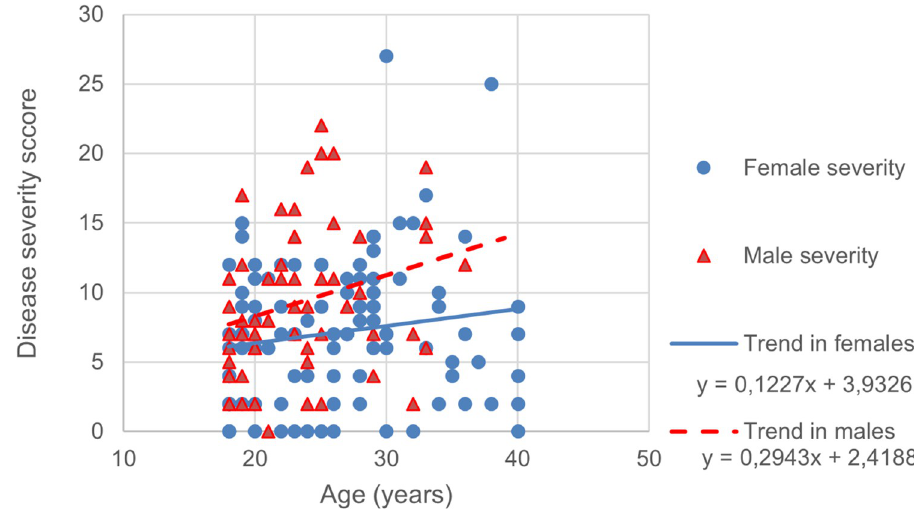
Fig 2. Distribution of disease severity score according to age and sex.